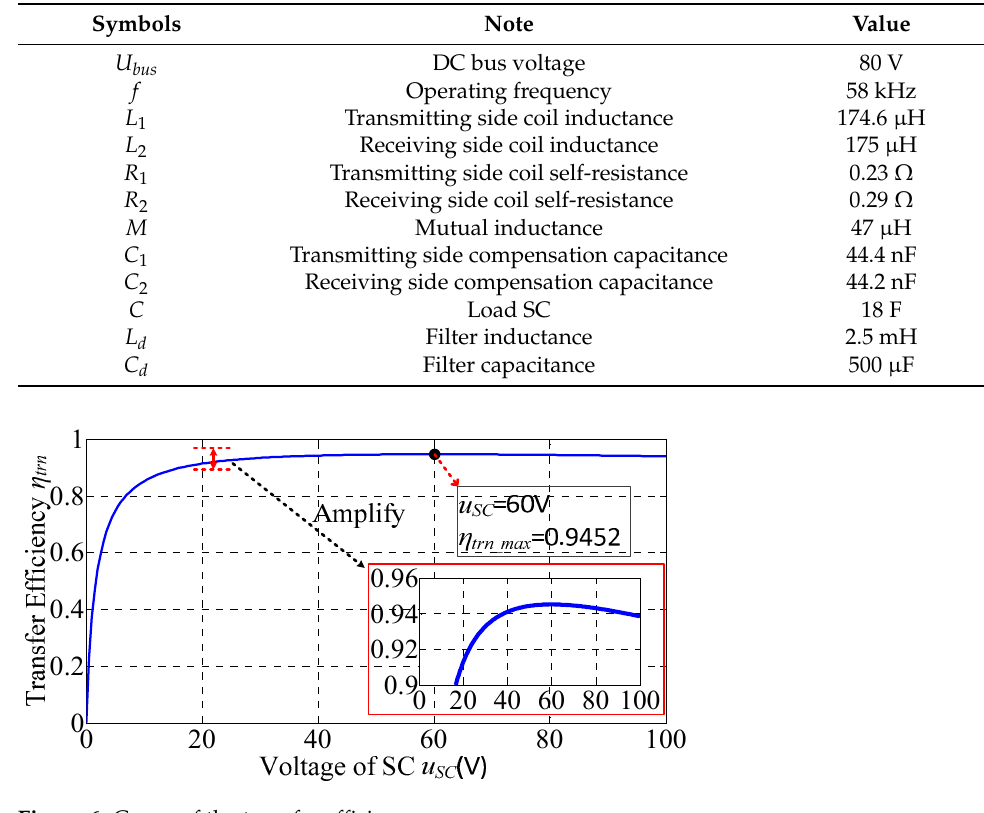
Figure 6. Curve of the transfer efficiency vs. u SC .